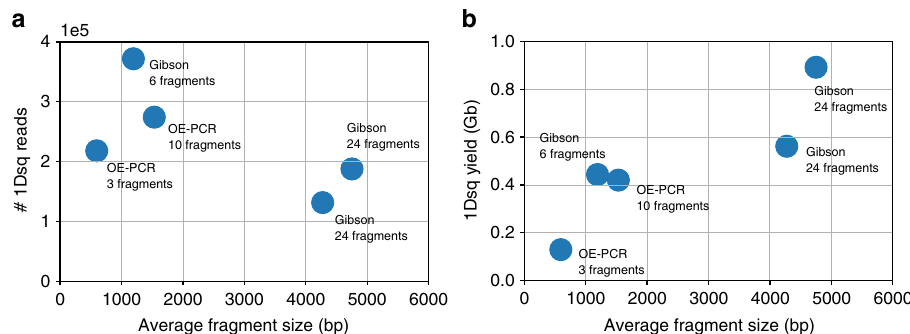
Fig. 5 Comparison between nanopore sequencing runs with different DNA fragment sizes. We compared fi ve nanopore sequencing runs of equivalent sequencing quality to understand how input DNA size affects sequencing throughput. a Number of 1D 2 sequencing reads generated in different sequencing runs. We found a modest decrease in the number of 1D 2 reads as the input DNA size increased. b 1D 2 sequencing yield (# of bases) generated in